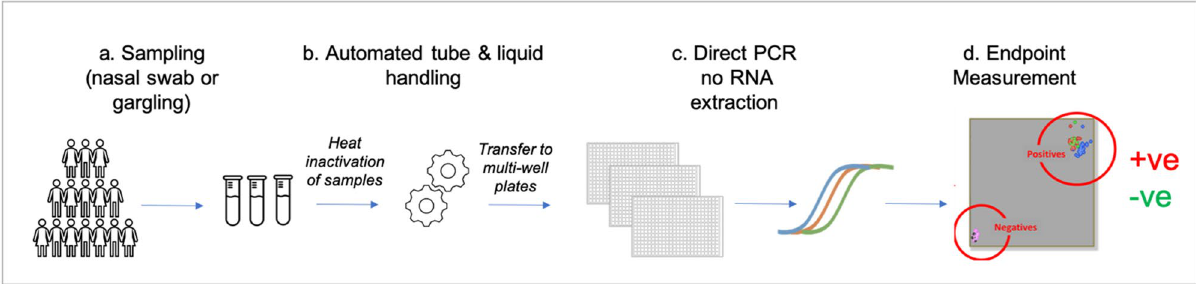
Figure 1. Schematic of the high throughput genome -based testing pipeline for SARS-CoV-2. ( a ) Sample tubes (barcoded) are brought to testing centres in 96-well carriers from collection points (e.g. see Fig. 2) and prepared for high-throughput testing for SARS-CoV-2 (or other viruses). Samples are heat inactivated before automated transfer in 384-well format ( b ) and preparation for ( c ) direct RT-PCR without a requirement for RNA extractions and ( d ) endpoint measurement showing results of test (positive,